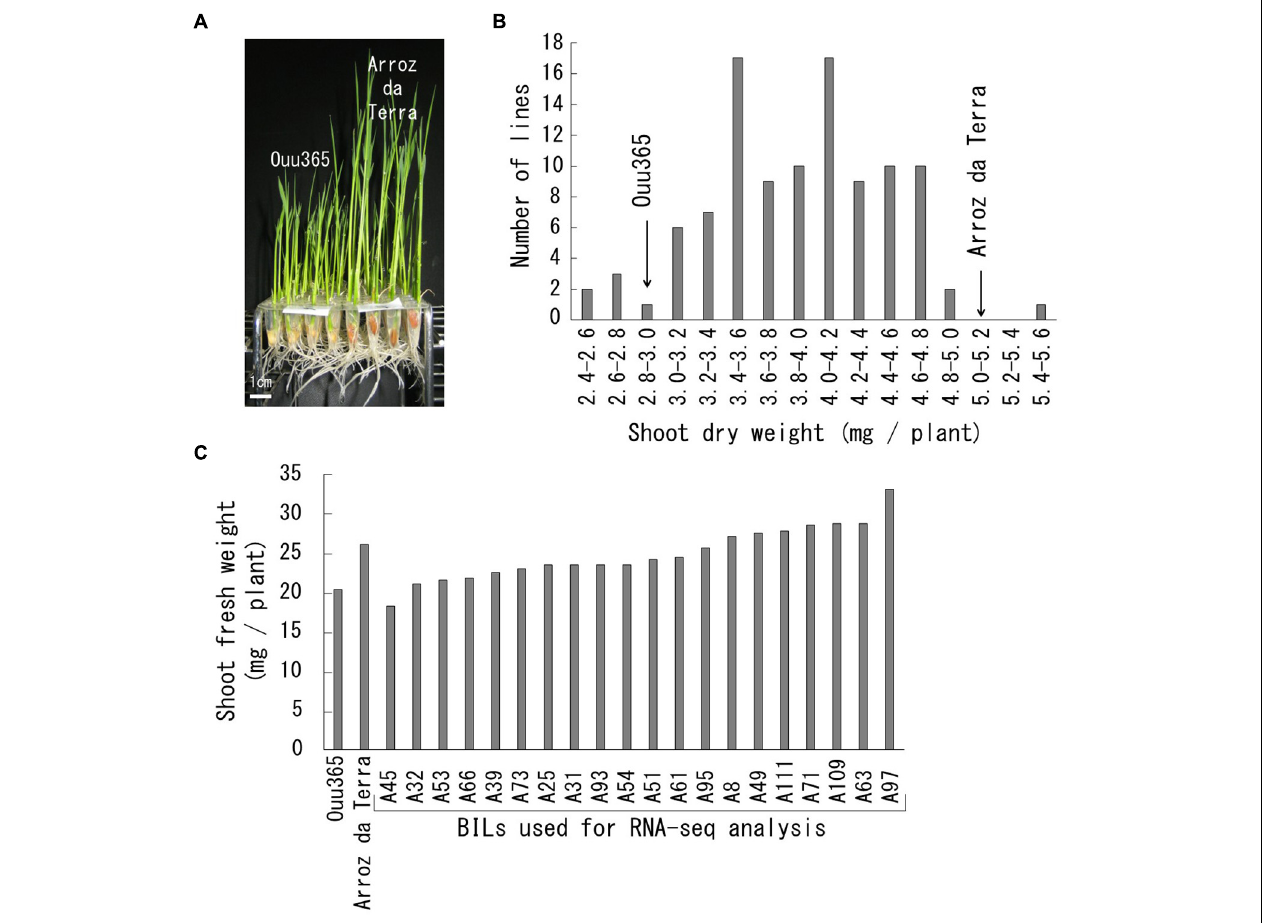
FIGURE 1 | Growth rate of Ouu365, Arroz da Terra, and BILs. (A) Ouu365 and Arroz da Terra seedlings 14 days after germination. (B) Frequency distribution of the shoot dry weights of 104 BILs. Arrowheads indicate the mean values of three biological replicates in Ouu365 and Arroz da Terra. (C) Shoot fresh weight of Ouu365, Arroz da Terra, and BILs used for RNA sequencing